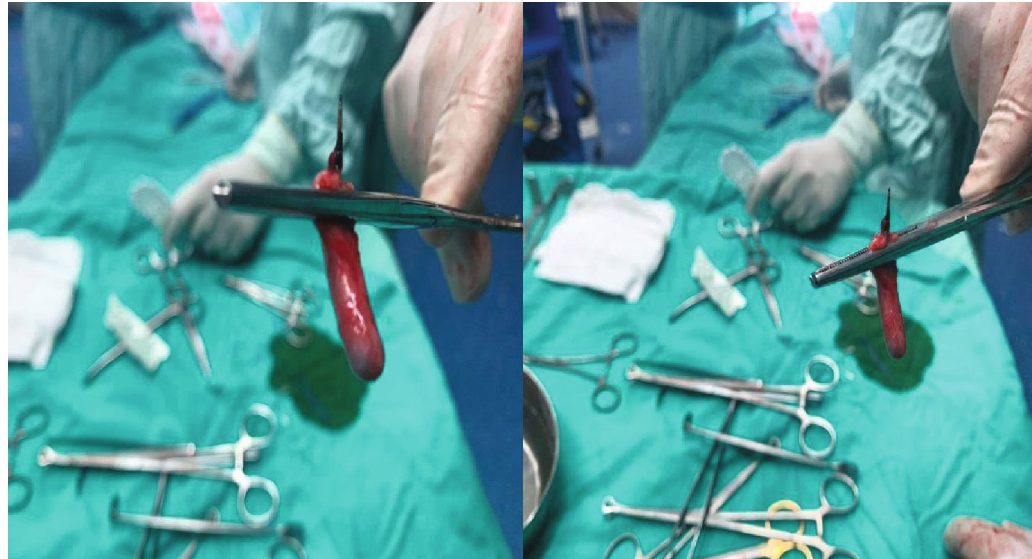
Figure 2: Metallic foreign body that obstructs the appendiceal lumen.